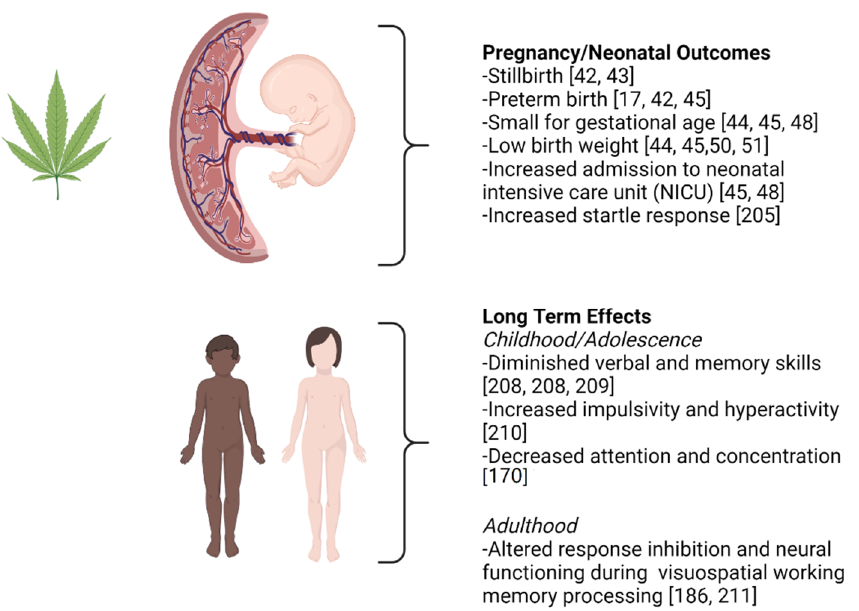
Figure 1. The effects of cannabis on human pregnancy outcomes as well as longer term effects postnatally are summarized . In considering the outcomes summarized here, it should be noted that the cannabis dosing in many of the studies in human participants is self-reported. Greater details about these studies can be found in body of this review. This figure was created using BioRender.com accessed on 5 August 2021.